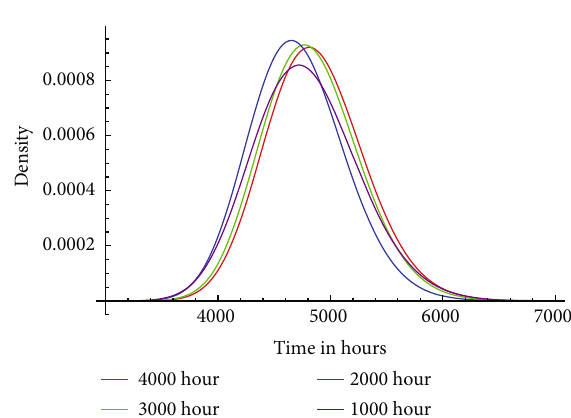
Figure 11: Inverse Gaussian probability densities of the time to failure for laser data available after the di ff erent test times.